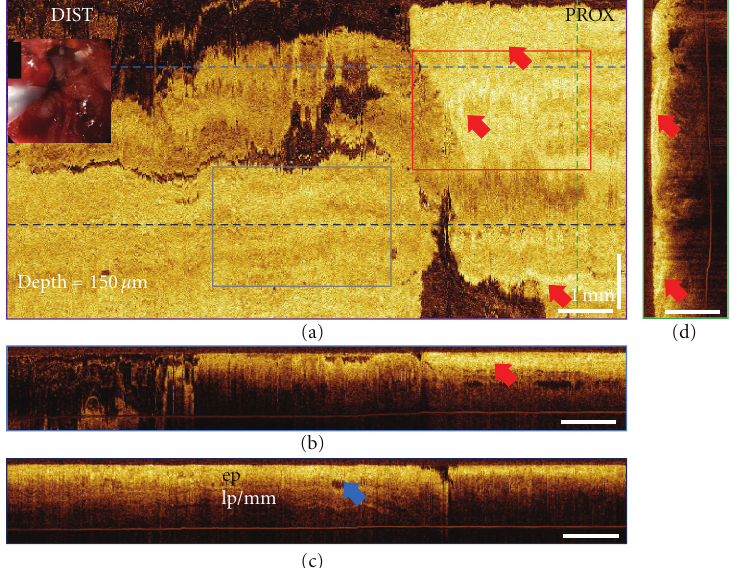
Figure 2: 3D-OCT orthoplanes from the BE region immediately after RFA treatment. (a) The en face orthoplane is located at a depth of 150 µ m. The colored dotted lines indicate location of complementary orthoplanes (b), (c), and (d). Red arrows indicate the locations of the burned tissue on top of the treated regions, and the blue arrow indicates the location of the residual gland. (b-c) The cross-sectional YZ orthoplanes show the epithelium (ep), lamina propria (lp), and muscularis mucosa (mm). (d) The cross-sectional XZ orthoplane shows the burned tissue right on top of the muscularis mucosal layer. Inset shows a video endoscopy image with the 3D-OCT probe in position prior to image acquisition. Red box and gray box indicate regions of interest in Figures 3(a)–3(c) and Figures 3(d)–3(f), respectively.